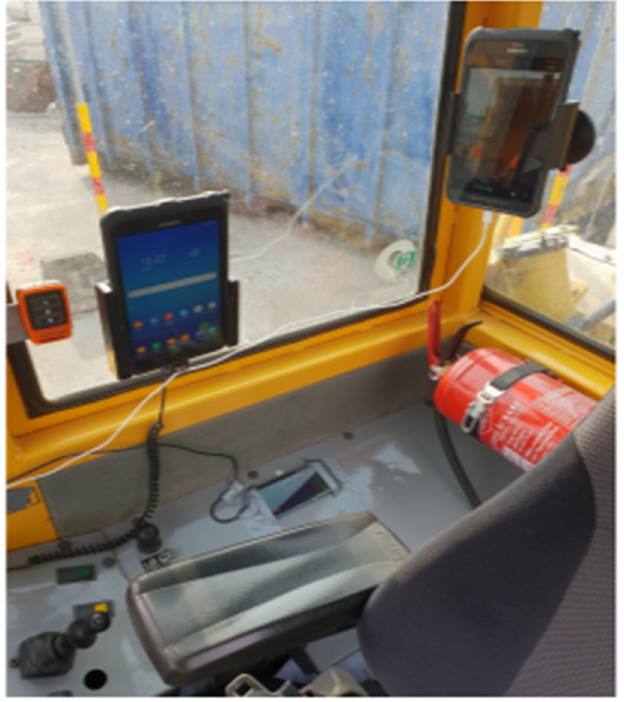
Figure 8. Taking sensor measurements using Smartphones to classify the state of a Dumper in an earth-moving site